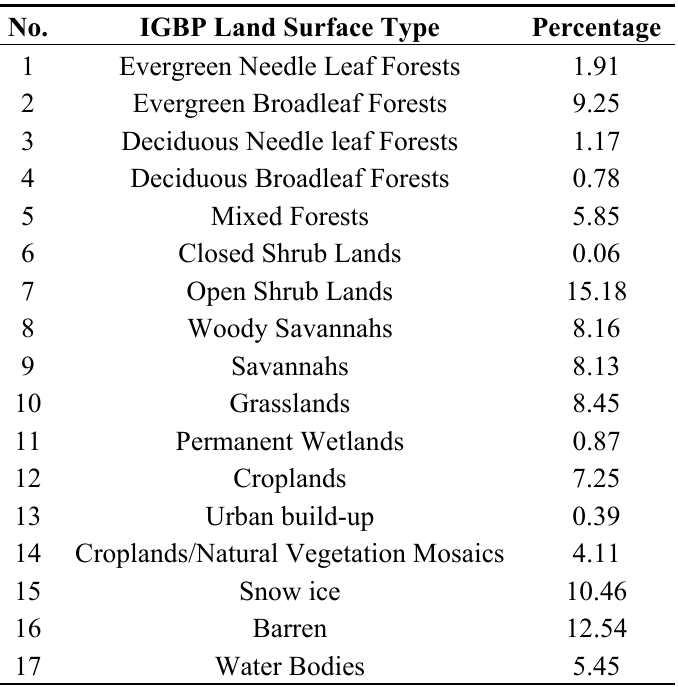
Table 2. Surface type distribution over